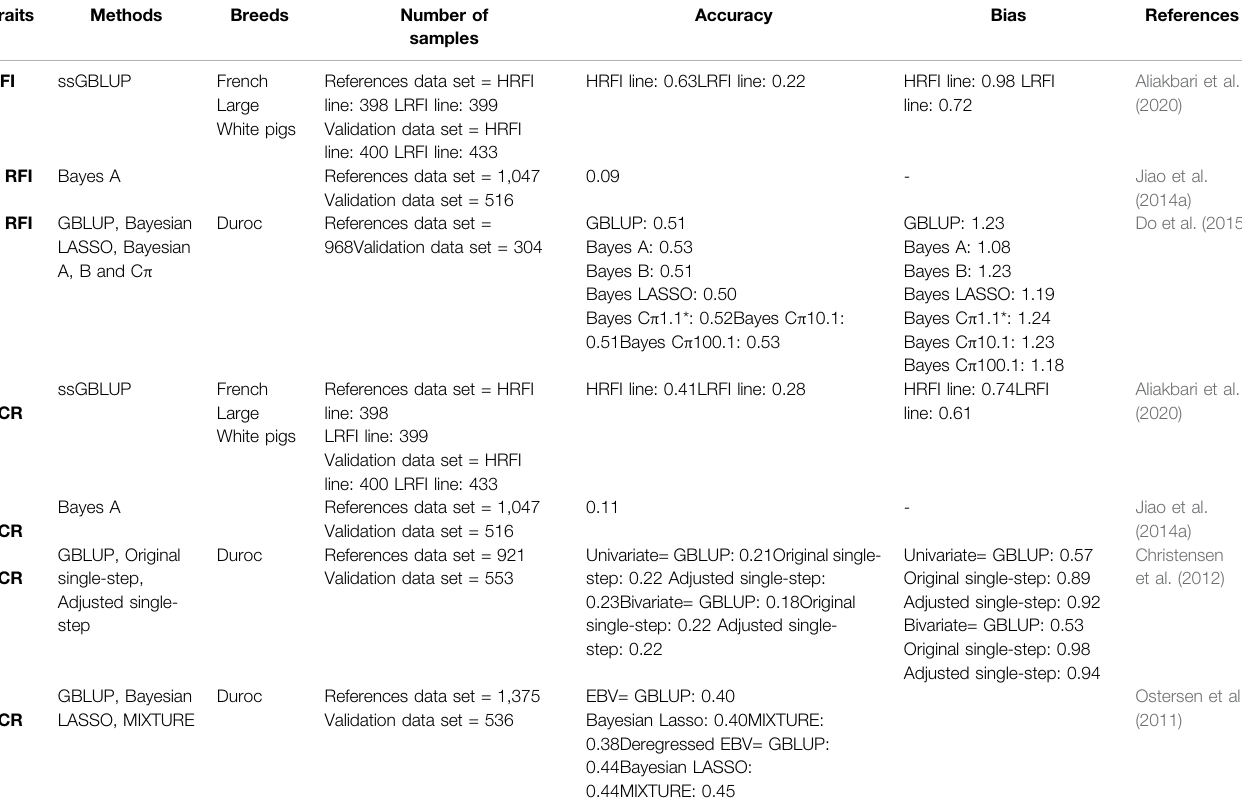
TABLE 1 | Literature estimates of genomic estimated breeding values (GEBVs) for feed ef fi ciency trait in pigs. Traits Methods Breeds Number of